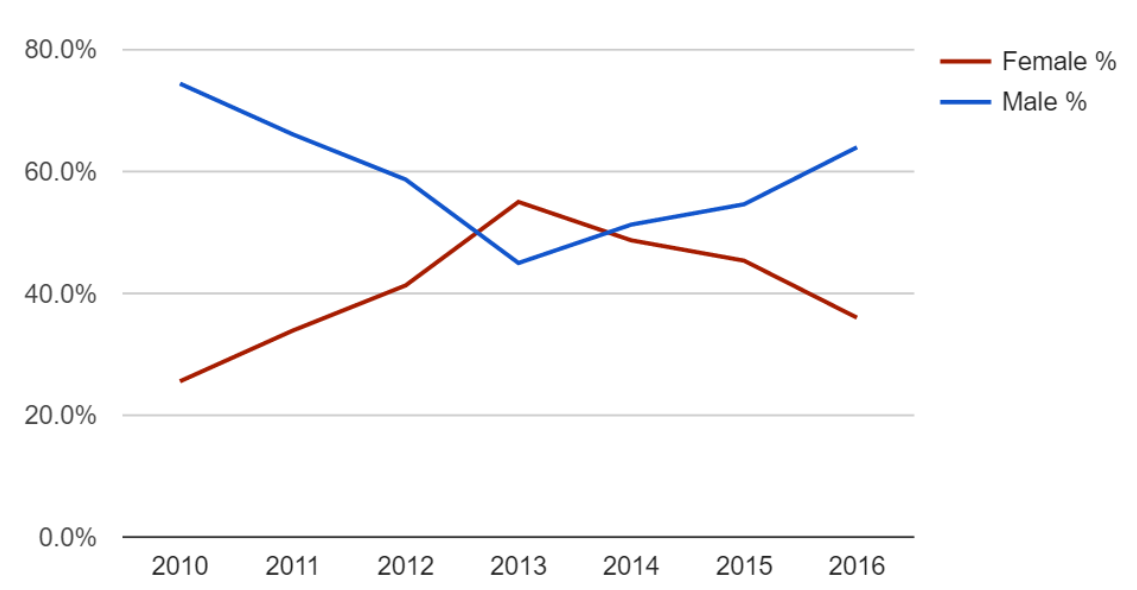
Figure 3. “Open” tweets by sampled user gender each